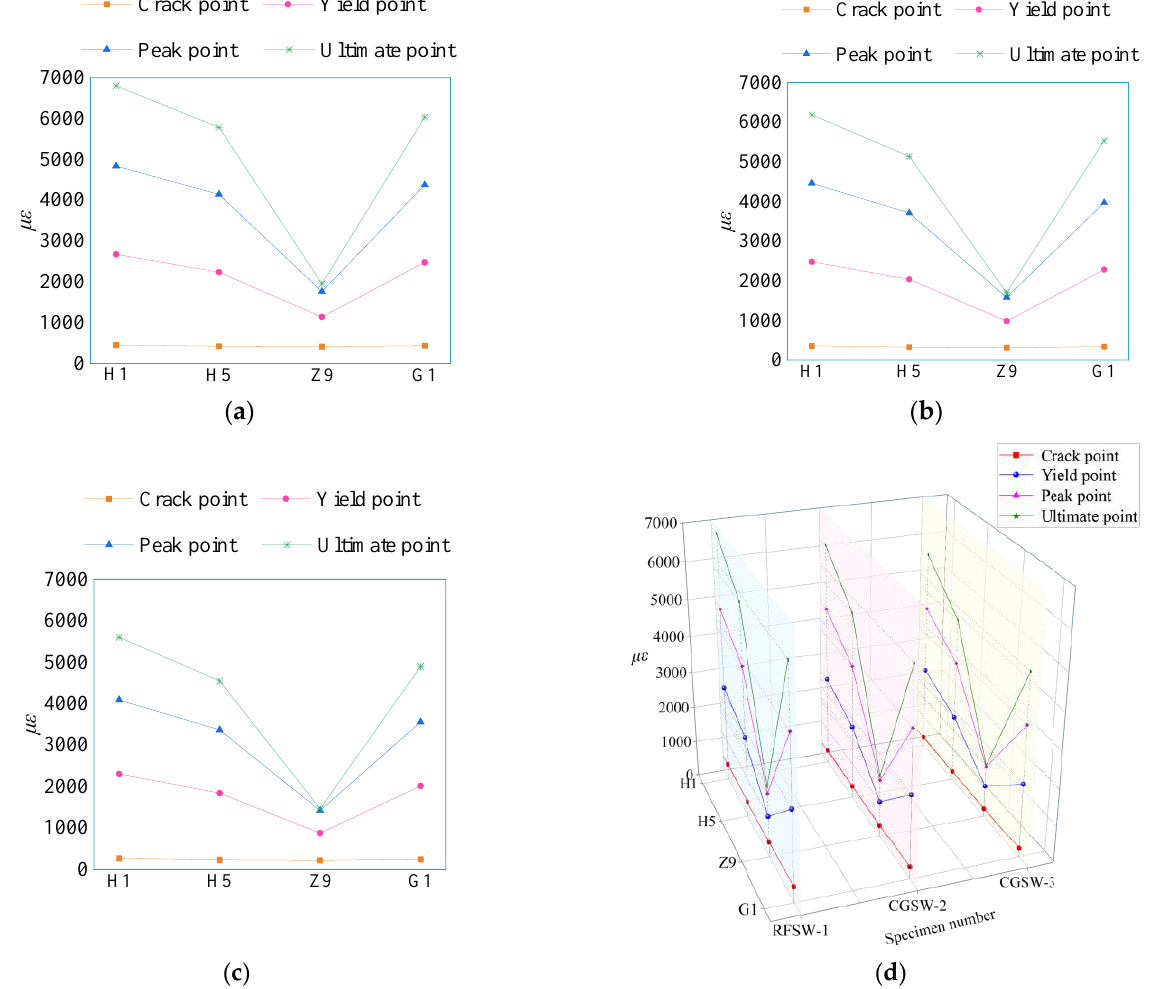
Figure 12. Strain curves of the specimens ( a ) RFSW-1 ( b ) CGSW-2 ( c ) CGSW-3 ( d ) Comparison.